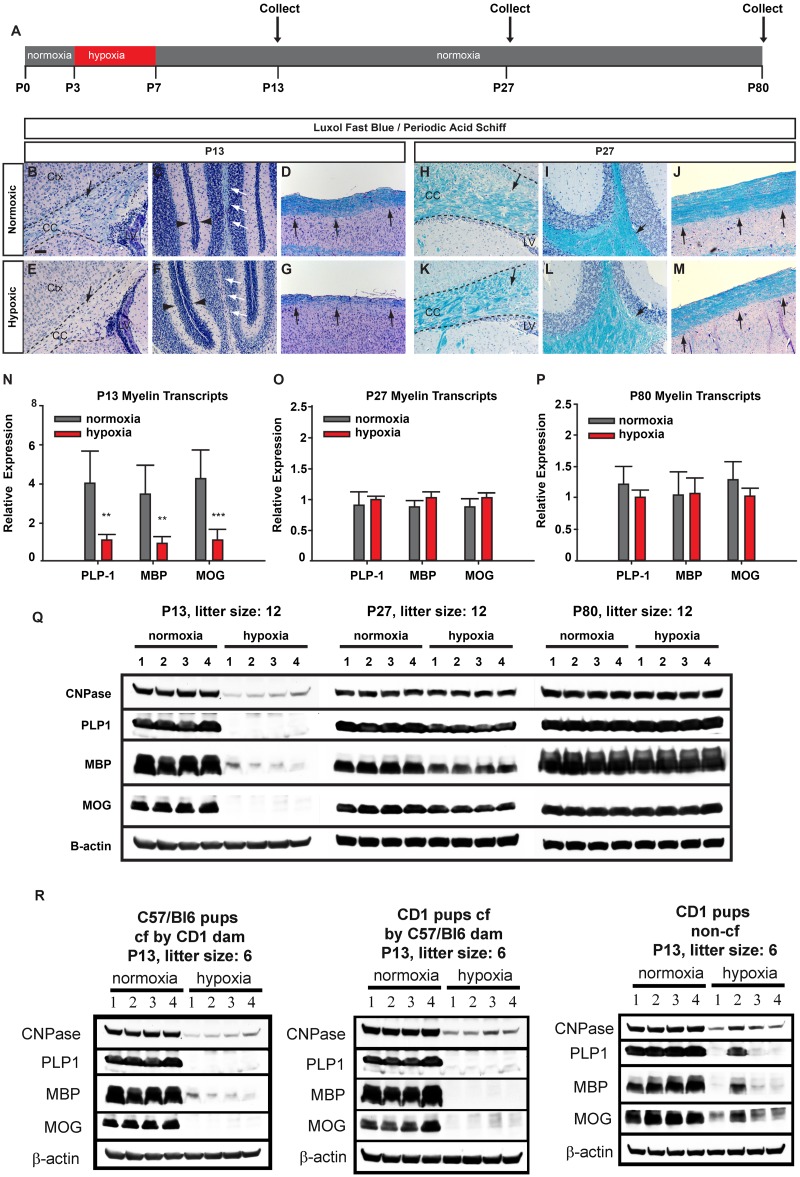
Abbreviated hypoxia is sufficient to induce CNS hypomyelination and does not require cross-fostering of neonatal mice.A: Experimental timeline showing CNS tissue collection from hypoxic (4 days of hypoxia) and normoxic CD1 mice at postnatal days 13, 27 and 80. B-M (Histology): Representative images of cerebrum (B, E, H, K), cerebellum (C, F, I, L) and spinal cord (D, G, J, M) of hypoxic and normoxic CD1 (non-cross-fostered) mice stained with myelin lipid dye Luxol fast blue (LFB) and Periodic acid—Schiff (PAS) (P13: B-G) (P27: H-M) at P13 and P27. At P13 black (cerebrum, spinal cord) and white (cerebellum) arrows indicate different levels of LFB staining in the corpus callosum (CC) respective differences in layer thickness in region matched areas from hypoxic and control mice. Black arrowheads indicate differences in external granular layer (EGL) thickness in cerebella between hypoxic and normoxic mice. At P27 black arrowheads indicate no obvious differences in LFB/PAS staining (H-M) between hypoxic and control CNS tissue in the corpus callosum, cerebellar white matter tracts and white matter in the spinal cord (n = 20 hypoxic animals P13; 14 normoxic animals P13; 4 normoxic animals P27; 4 hypoxic animals P27). N-P: RNA transcript levels of myelin splice variants PLP-1, MBP-1 and MOG from hypoxic or age-matched mouse control cerebra at P13, P27 and P80 shown as mean ± std.-dev. from 6 hypoxic + 6 normoxic animals per time point with *** equals p < 0.001; ** equals p < 0.01; * equals p < 0.05. Q: Representative Western blots showing protein levels of cerebral myelin markers CNPase, PLP, MBP and MOG (1.5 mg tissue loaded per lane) at P13, P27 and P80 with each lane representative for an individual animal. β-actin was used as a loading control. Litter sizes in A-Q were 12 neonatal mice per dam. R: Representative Western blots of myelin proteins identical to Q using total brain lysates from cross-fostered and non-cross-fostered CD1 and C57/Bl6 mice at P13. Litter sizes in R were 6 neonatal mice per dam. Ctx = cortex, CC = corpus callosum.